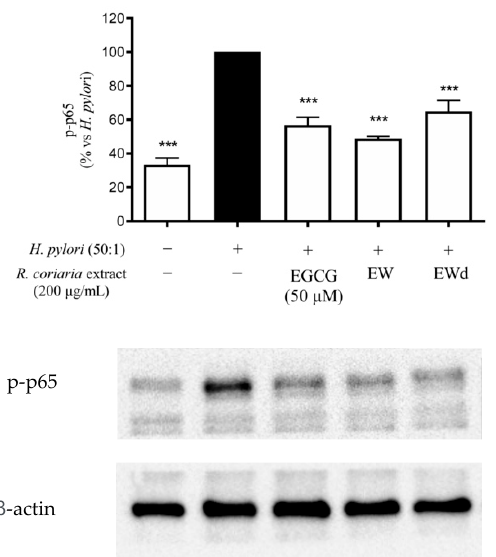
Figure 7. Effects of Rhus coriaria L. non-digested (EW) and digested (EWd) ethanol–water extracts on p-p65 activation in GES-1 cells treated with the stimulus H. pylori ( H. pylori : cell ratio 50:1) for 1 h. The reference compound (black color) used was EGCG 50 μ M ( − 43%). *** p < 0.001 versus H. pylori . p-p65, phospho-p65.